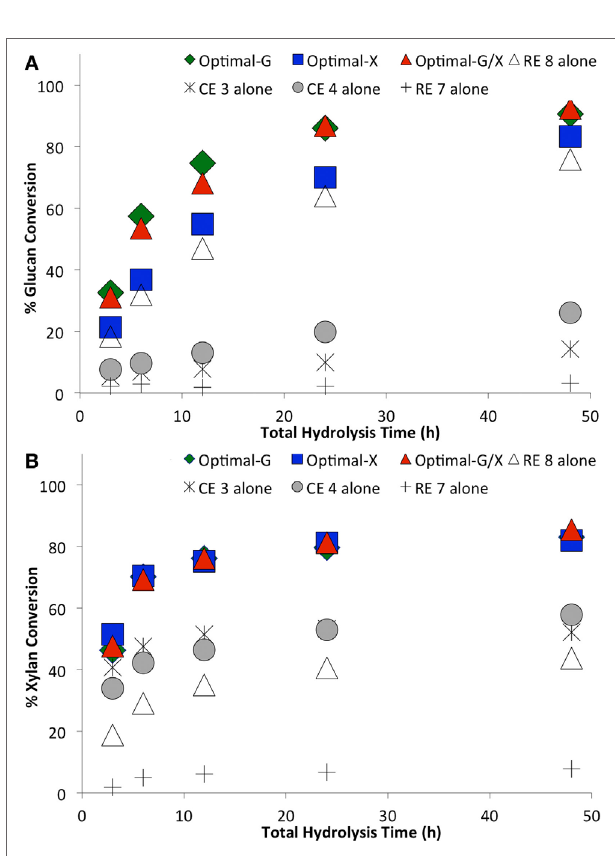
FigUre 4 | comparing optimal versus non-optimal commercial enzyme (ce) combinations on glucan-to-glucose (a) and xylan-to- xylose (B) percent conversions for ammonia fiber expansion-treated corn stover as a function of hydrolysis time . Total protein loading was 30 mg/g glucan. Optimal G, optimal X, and optimal G/X represent enzyme combinations that gave the highest glucose, xylose, and total sugar (glucose + xylose) yields, respectively. Mean values are reported here, while SDs in all cases was less than 2% and is not shown here for sake of clarity.